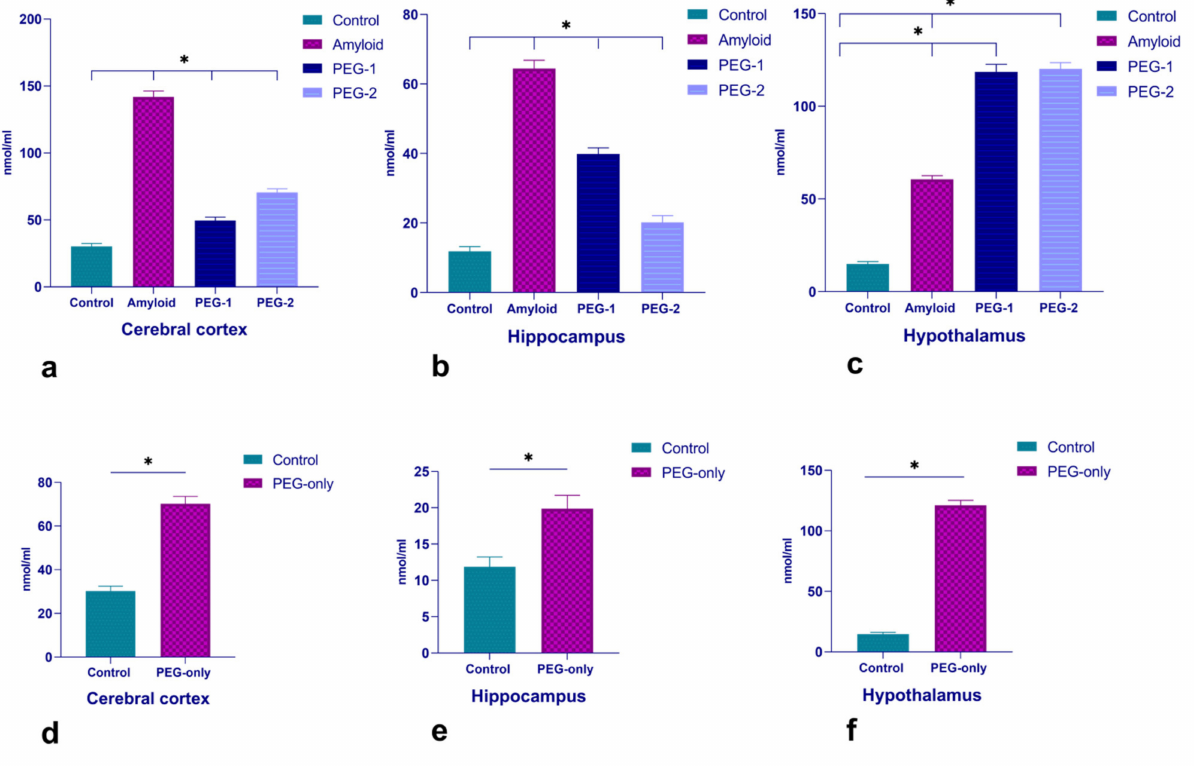
Figure 1. Changes of the IGF-1 concentration at neurodegeneration and under PEG influence. The concentrations of the IGF-1 in control, amyloid, PEG-1 and PEG-2 groups ( a – c ), as well as under the influence of PEG only ( d – f ). The data are represented in nmol/mL form. p -values below 0.05 (*) were considered as statistically